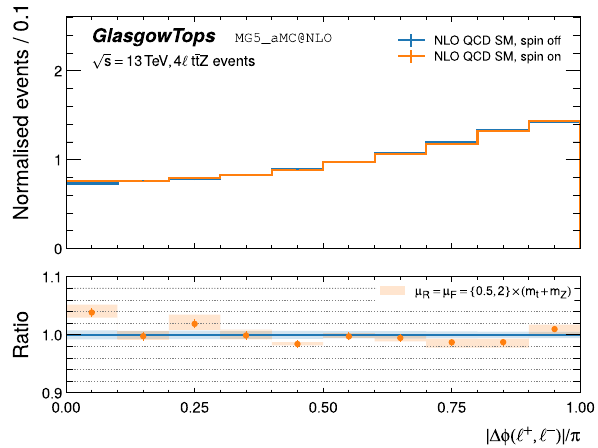
) | in 4 (cid:10) t ¯ tZ events, Fig. 1 Normalised distribution of | (cid:17)φ((cid:10) + t ,(cid:10) − ¯ t under the assumption of SM-like (orange) and no spin correlations (blue). In the bottom panel, the orange error bars and the blue error band represent the Monte Carlo statistical uncertainties on these two distributions. The orange error band further corresponds to the scale uncertainty obtained by varying μ R and μ F together by a factor of 2